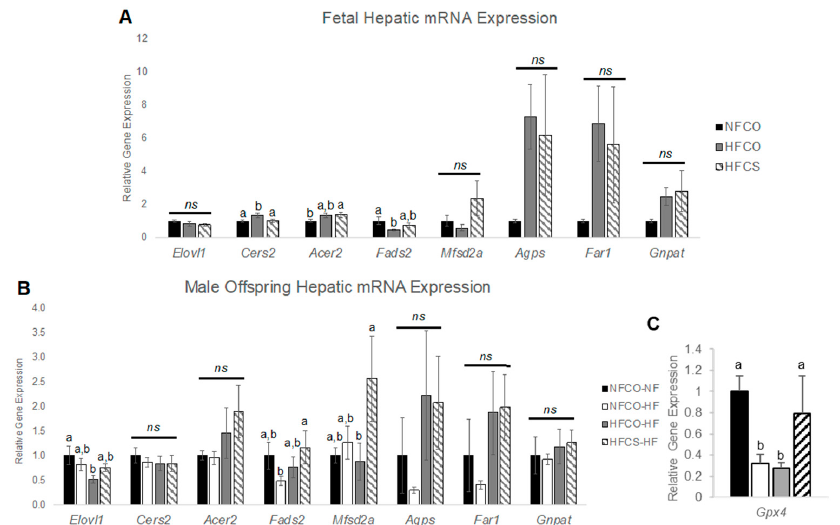
Figure 6. Fetal and Postnatal Hepatic Gene Expression of Proteins Involved in Lipid